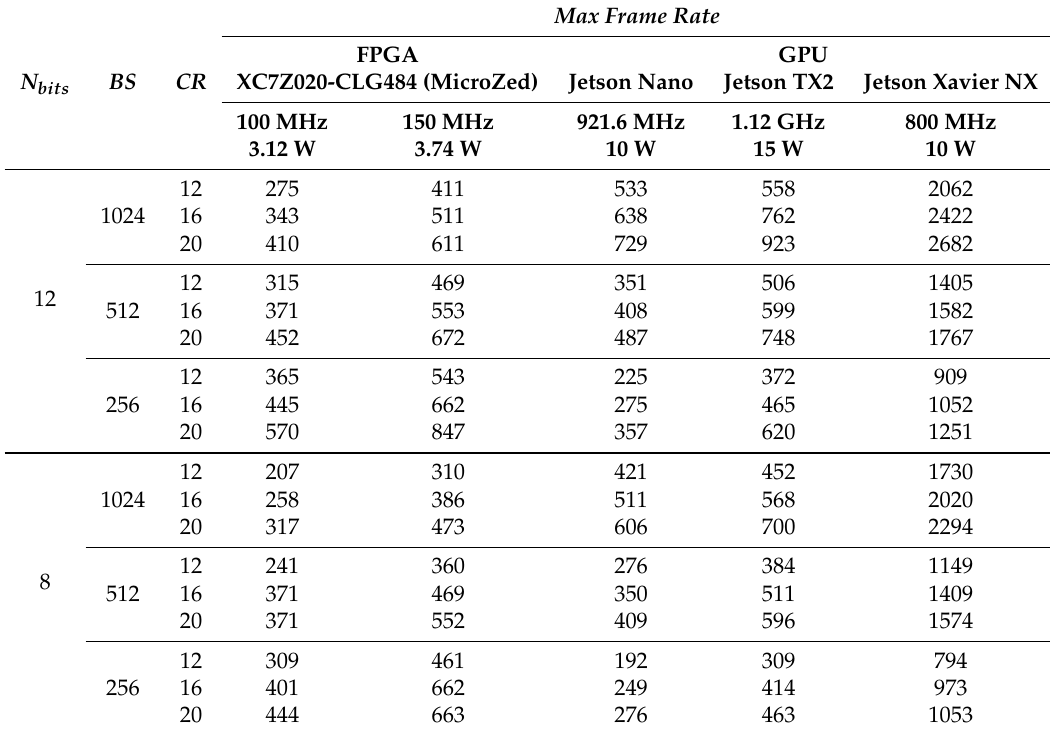
Table 9. Maximum frame rates obtained by the proposed FPGA implementation and the GPU-based model introduced in [29] for the NVIDIA boards Jetson Nano, Jetson TX2 and Jetson Xavier